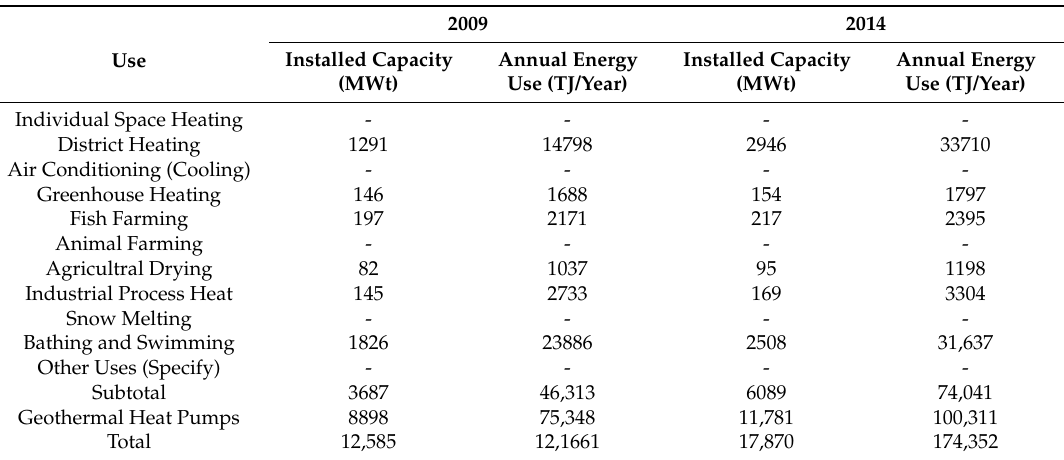
Table 4. Geothermal direct uses in 2009 and 2014